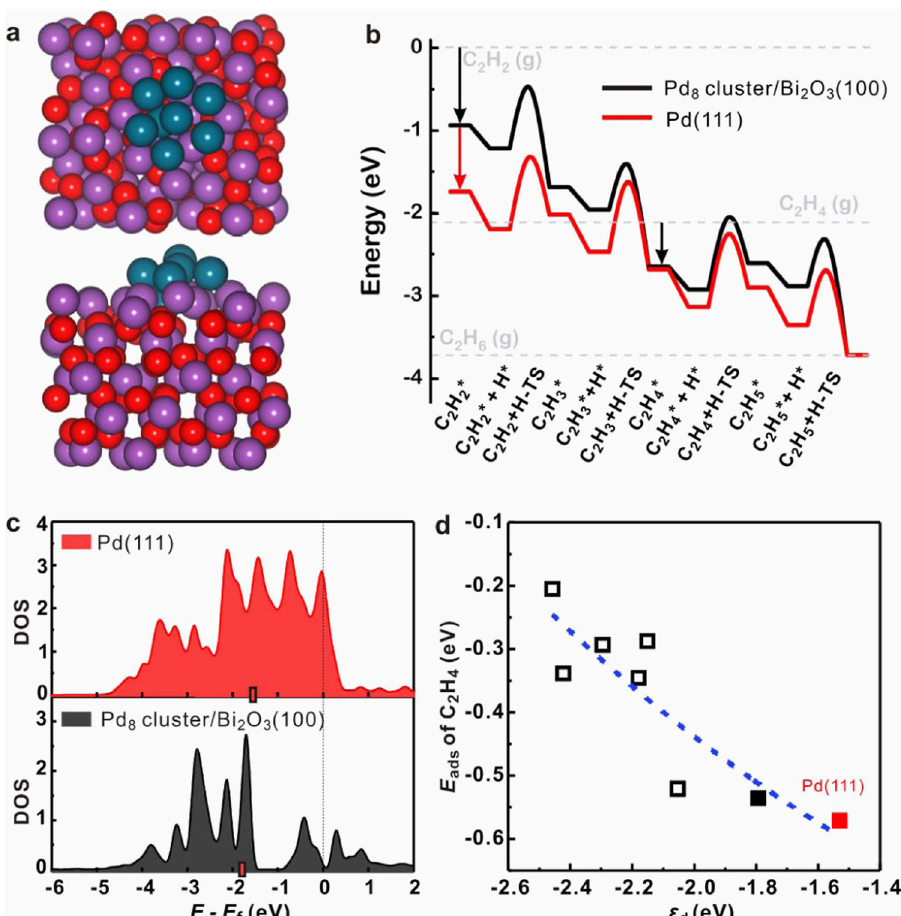
Fig. 4 Reaction mechanism revealed by DFT calculations. a Optimized Pd cluster structure for DFT calculation (Pd: cyan, Bi: purple, O: red) and b energy pro fi le of acetylene hydrogenation to ethane on Pd(111) and Pd 8 cluster supported on Bi 2 O 3 (100). c DOS projected onto d electrons over Pd atom of Pd(111) and Pd 8 cluster structures. A surface Pd atom of Pd(111), and the most active Pd atom of Pd 8 cluster structure (on which C 2 H 4 adsorbs most strongly) are chosen to plot the DOS. The position of d -band center ( ε d ) is highlighted with a red bar. d E ads of C 2 H 4 as a function of ε d over different Pd atom on Pd cluster surface (black squares). The most stable adsorption con fi guration is shown as solid square, while the other less stable adsorption structures are denoted by hollow squares. A surface Pd atom of Pd(111) is also shown as red solid square for comparison. The blue fi tted line is a guide for the eyes. It shows that a more negative ε d corresponds to a more positive E ads of C 2 H 4 . Source data are provided in a Source data fi